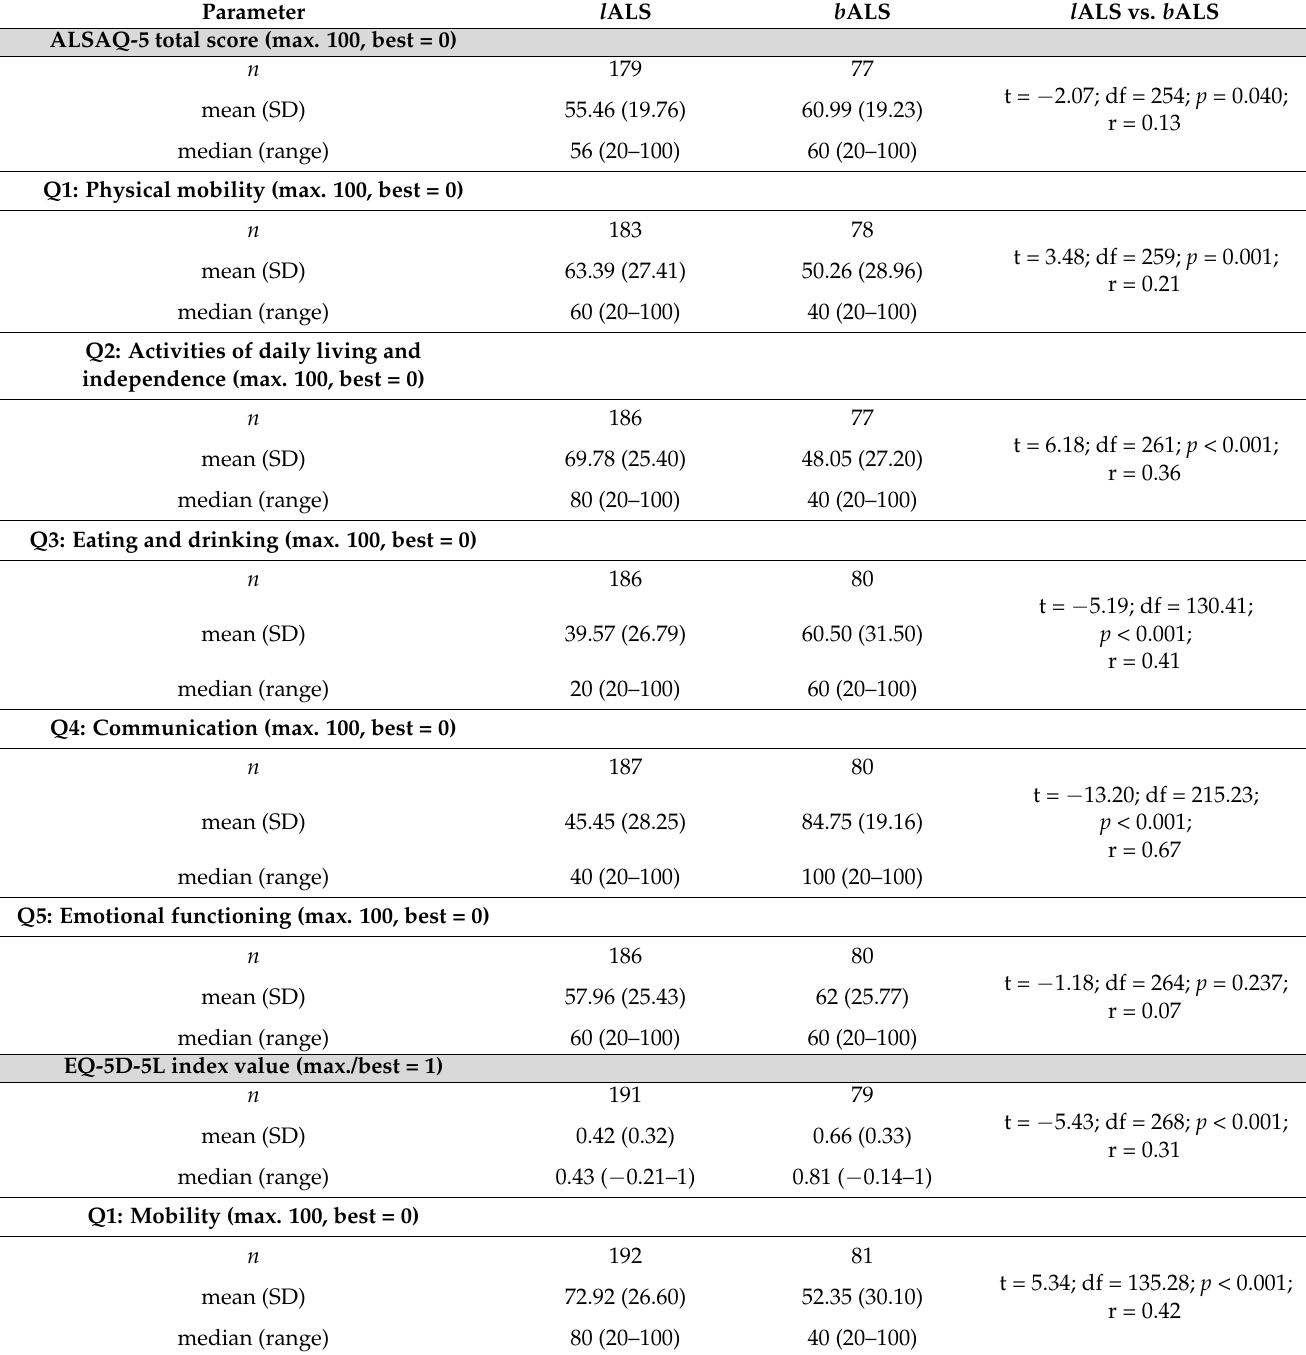
Table 3. Comparison of the difference in QoL (both overall and specifically relating to the different dimensions of the questionnaires) between l ALS and b ALS patients based on the total mean scores and individual question scores of the ALSAQ-5 and EQ-5D-5L questionnaires, with n representing the number of patients who answered the specific question. In order to directly compare the results of the individual questions of the two questionnaires, the individual question scores of the EQ-5D-5L (ranging from 1–5), were converted, by taking the score provided, ranging from 1–5, dividing it by 5, as there were five options, and then multiplying that number by 100, to a scale from 0–100, with 0 = best QoL. Effect sizes of r = 0.50, r = 0.30, and r = 0.10 served as thresholds for large, medium and small effects [65], respectively. Abbreviations: ALSAQ-5, Amyotrophic Lateral Sclerosis Assessment Questionnaire 5; b ALS, “bulbar-onset” ALS; df, degrees of